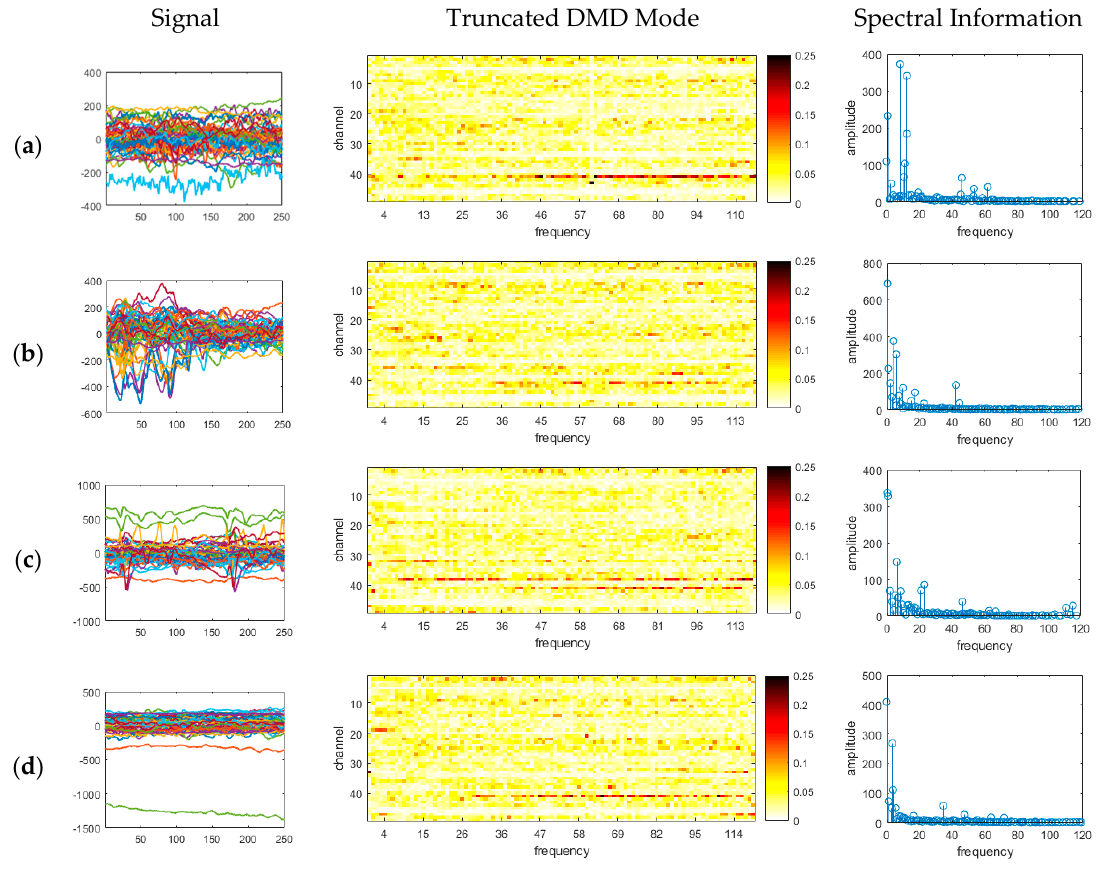
Figure 5. Examples of the patterns of DMD modes ( a ) for interictal signals in the awake state, ( b ) for interictal in sleep, ( c ) for ictal in awake, and ( d ) for ictal in sleep. This displays the truncated DMD mode in Equation (10) and the spectral information in Equations (13) for a segmented signal. The high-frequency pattern of the ictal signal appears more clearly than that of the interictal signal does.